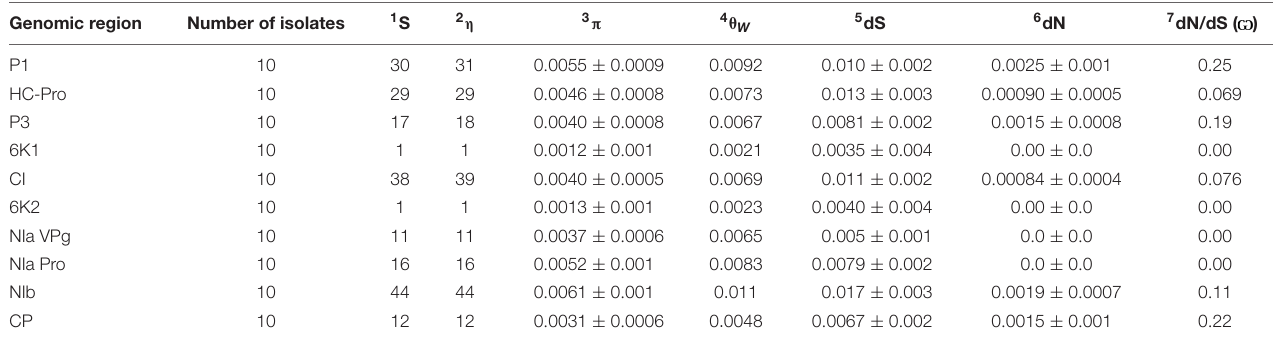
TABLE 2 | Population genetics parameters calculated using DnaSP and MEGA for encoded regions of TriMV. Genomic region